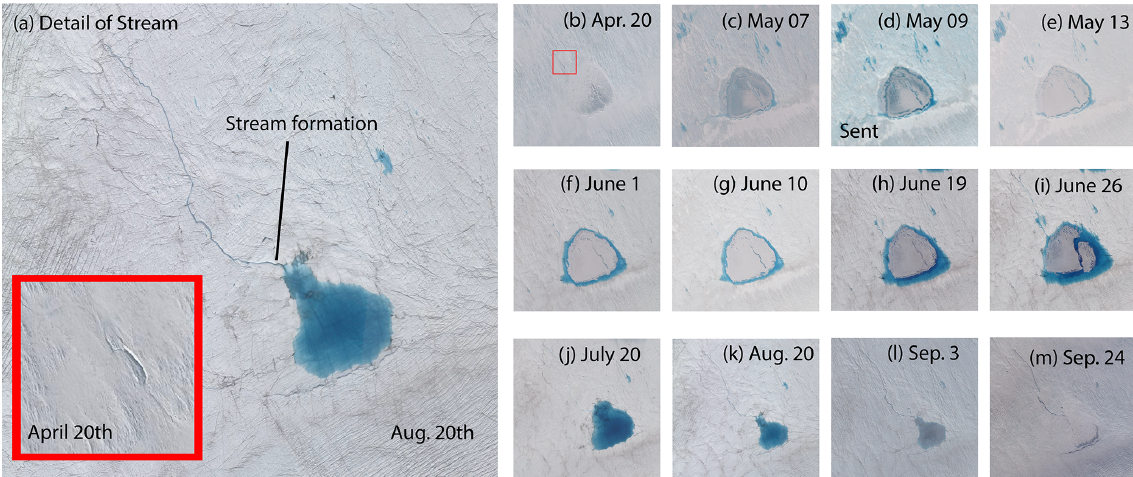
Figure 11. Lake Niels shown between 20 April and 4 September 2019. Panel (a) shows stream detail from 20 August (main panel) with stream detail on 20 April (inset, with region indicated in panel b ). All imagery is from Planet SkySat Visual imagery except on 9 May (when Sentinel-2 imagery is used, indicated with